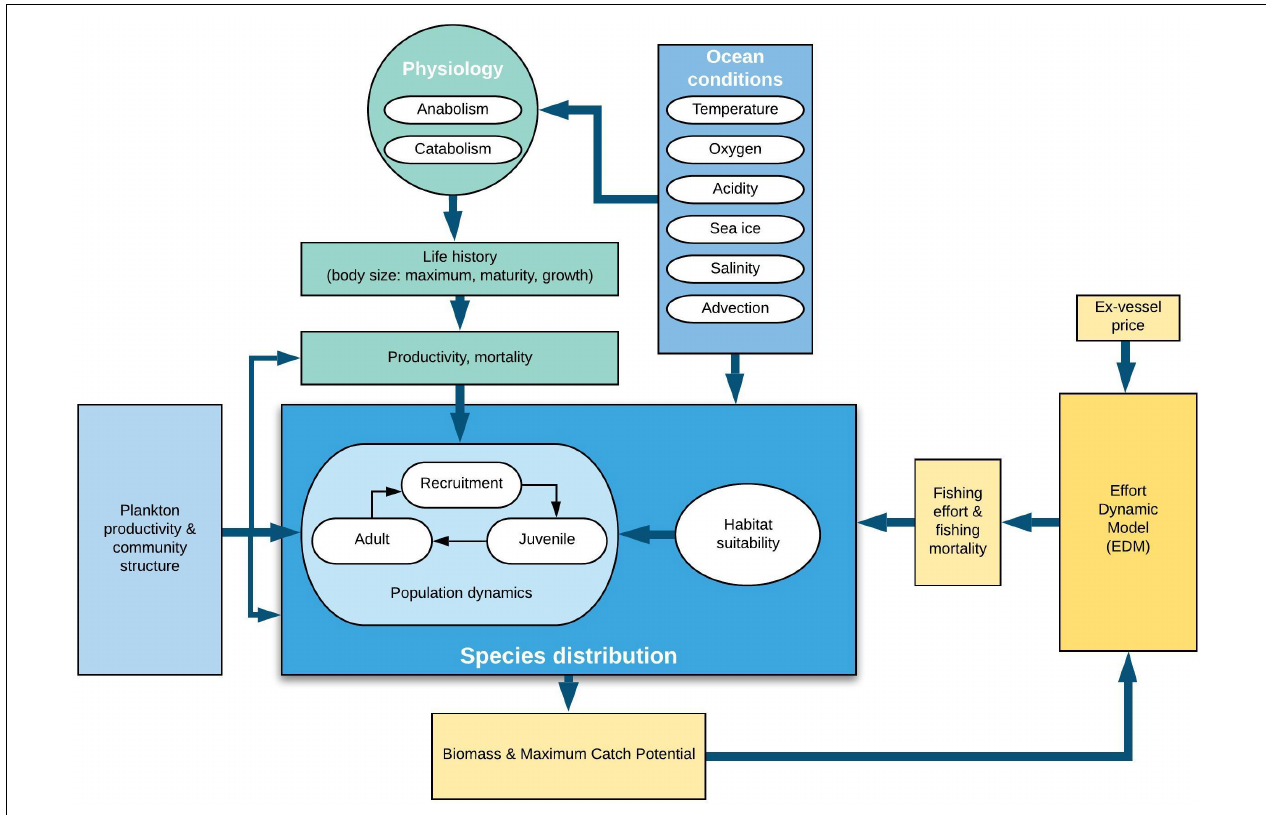
FIGURE 2 | Structure of the coupled Dynamic Bioclimate Envelope Model (DBEM) – Effort Dynamic Model (EDM) in this